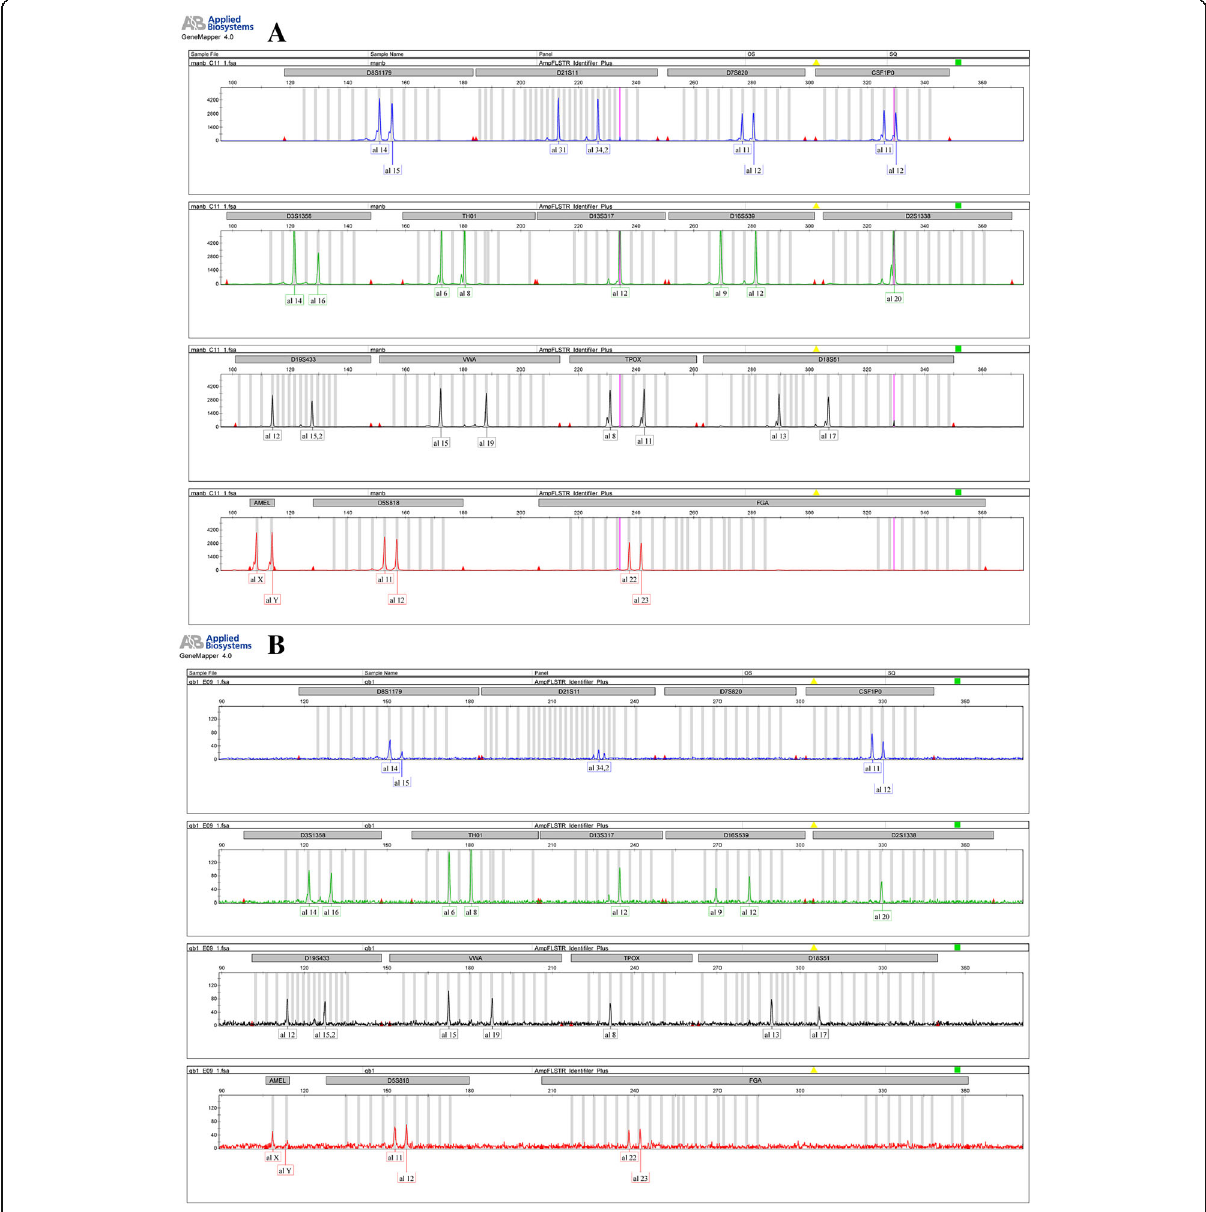
Fig. 5 Electropherograms of the interpretable profile (12/16 loci): reference profile ( a ) and profile obtained from gauzes ( b